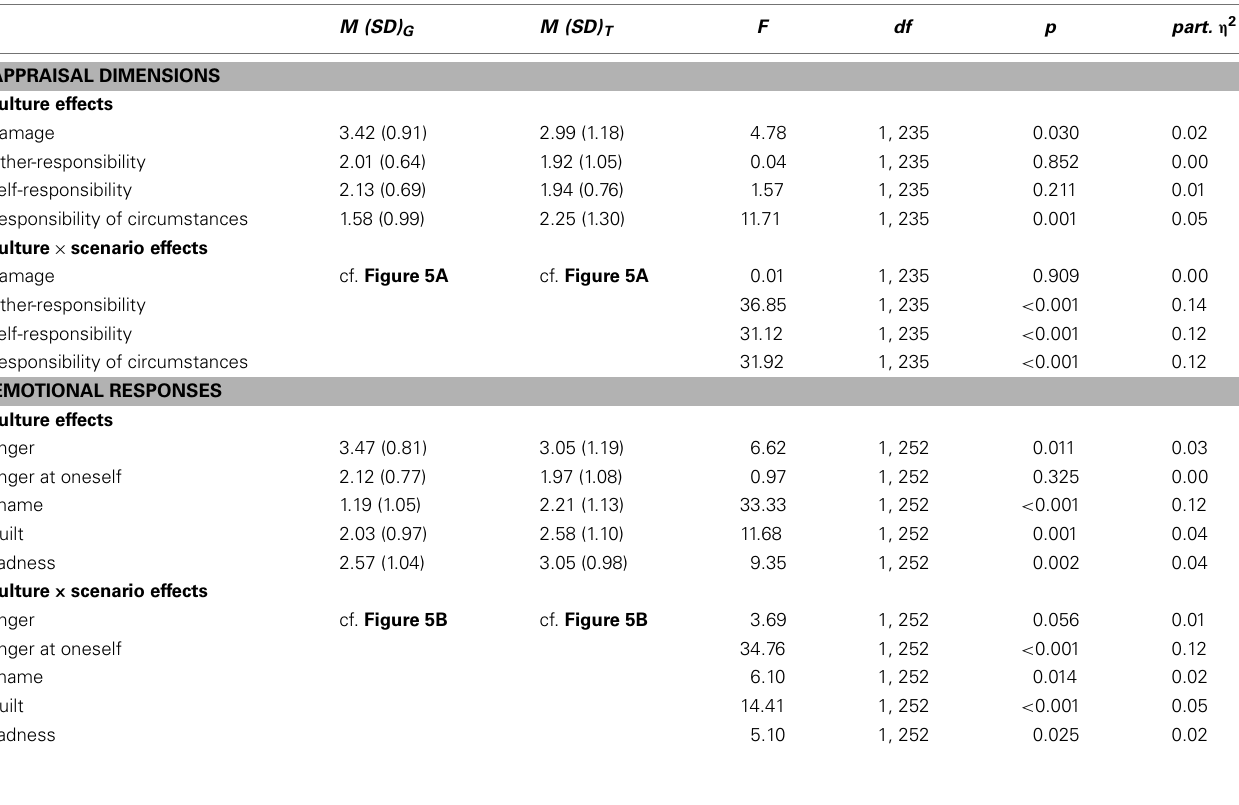
Table 3 | Univariate effects of (a) appraisal dimensions and (b) emotional responses for the other-caused (OC) vs. self-caused (SC)